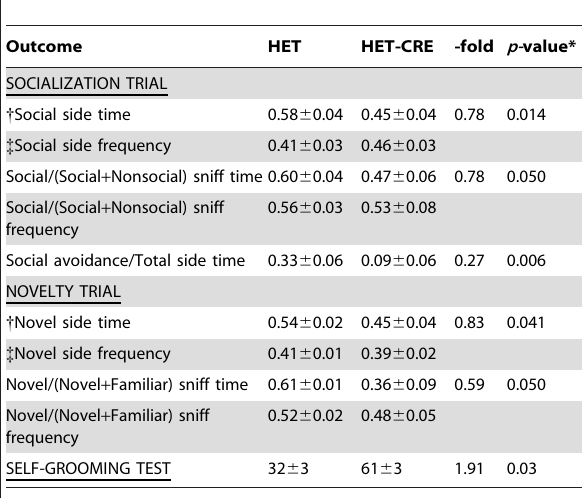
Table 2. Behavioral tests performed on HET and HET-CRE mice aged 20–29